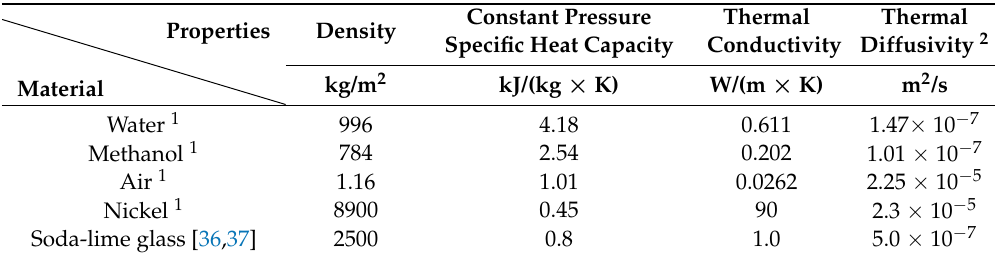
Table 2. Literature values of the thermal properties of the materials used in our experiments.